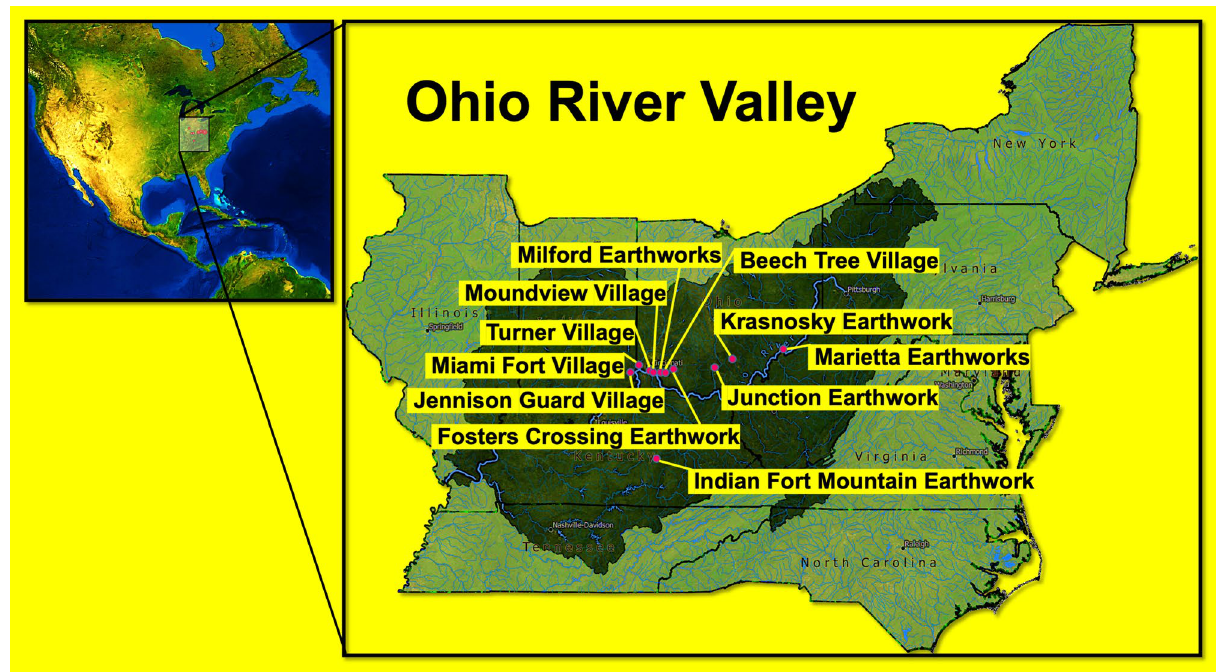
Figure 1. Geographic setting of Hopewell archaeological study sites for airburst-related proxies: Jennison- Guard village site, Indiana; Miami Fort hilltop earthworks, Ohio; Turner earthworks and village,